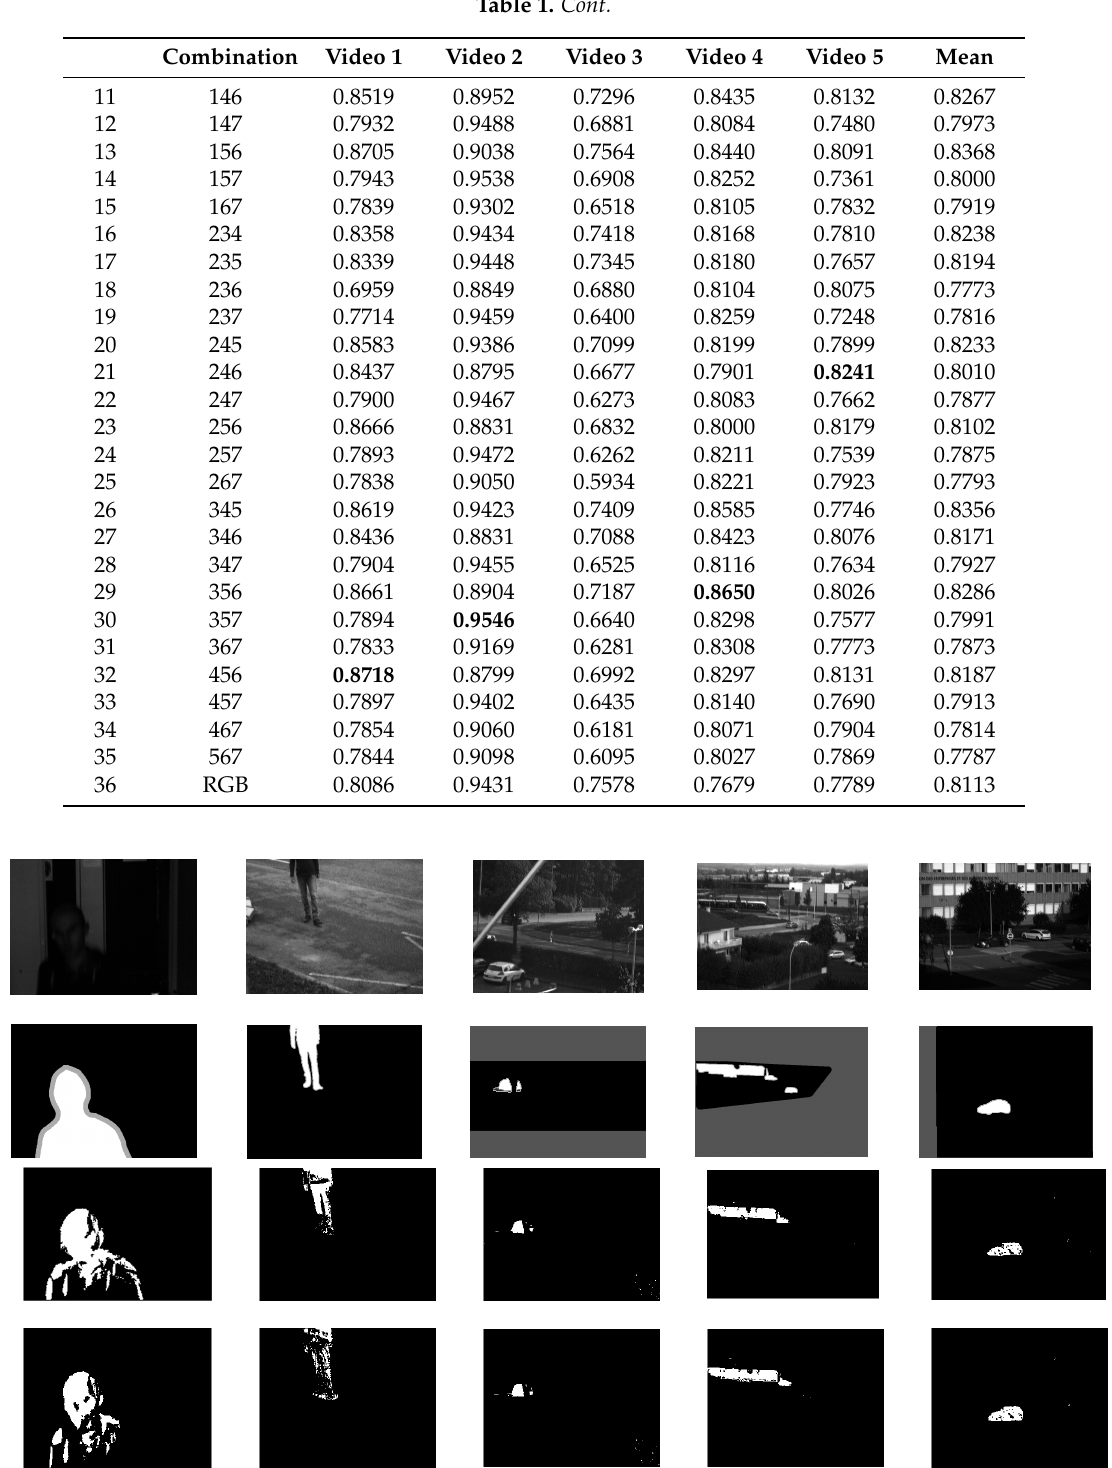
Figure 4. Background subtraction results on five videos. The top row is original multispectral sequences. The second row is the corresponding ground truth. The third and fourth are the results obtained by the respective best combination of multispectral and RGB sequences.